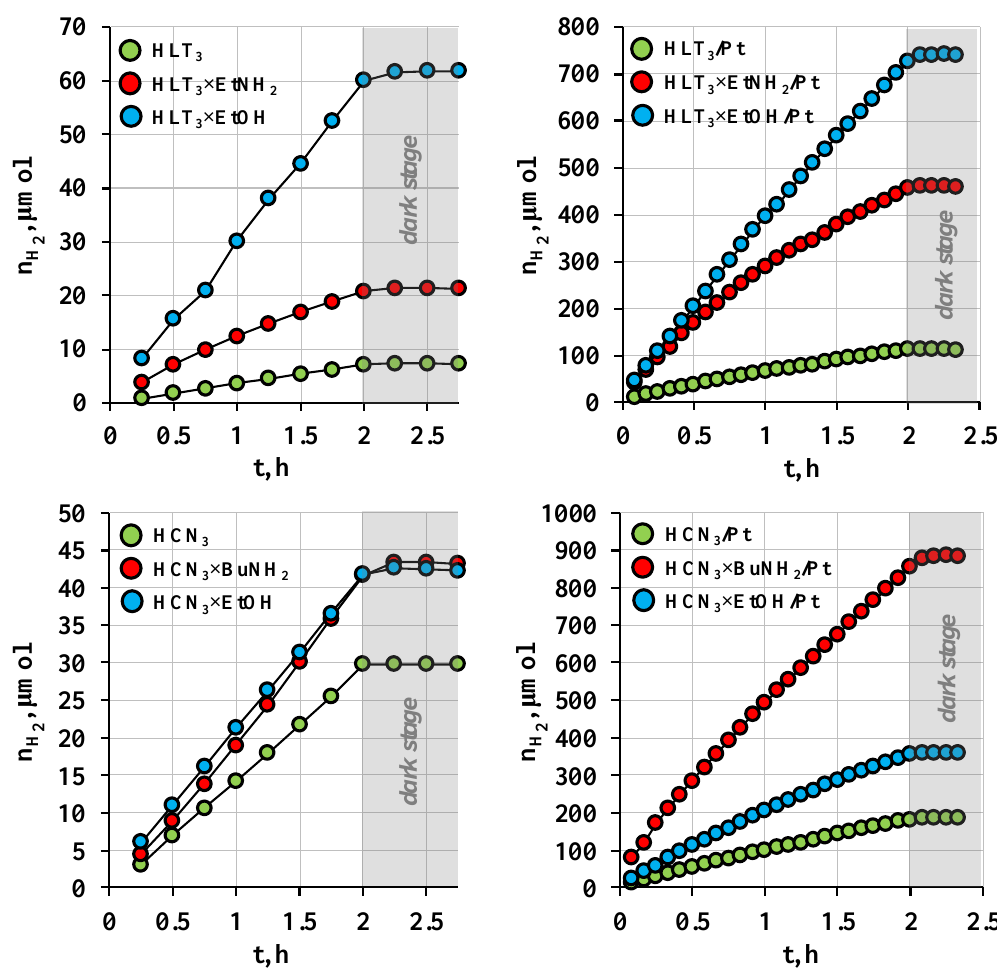
Figure 2. Kinetic curves of hydrogen generation from 1 mol. % aqueous D-glucose over the proto- nated oxides, inorganic − organic derivatives, and products of their in situ platinization under near ultraviolet irradiation.